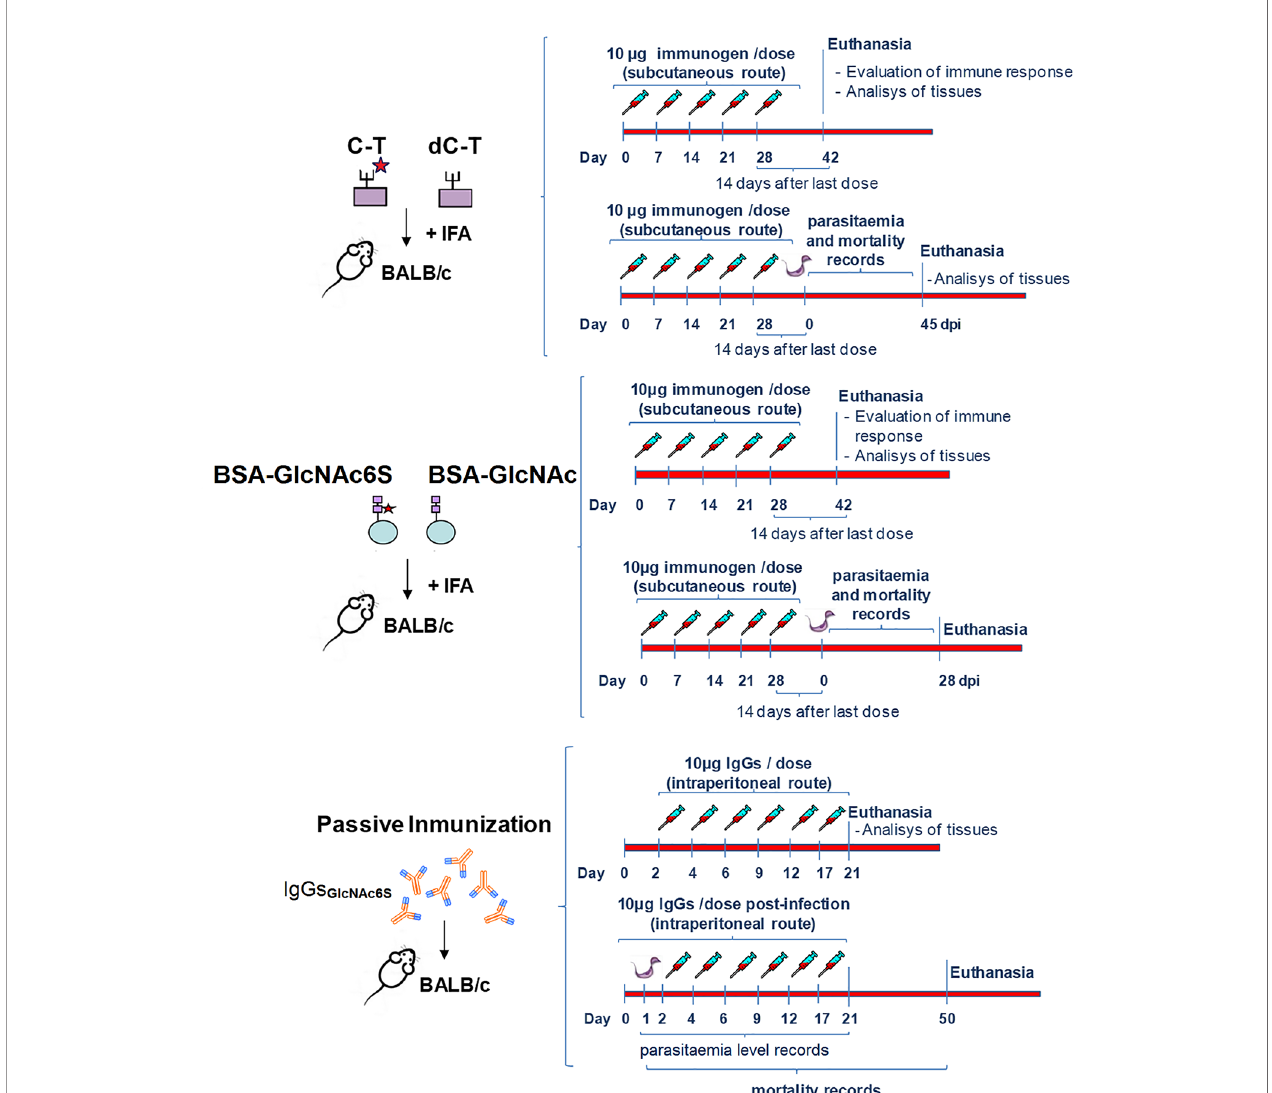
FIGURE 1 | General scheme of immunization from BALB/c mice to study: the input of sulfotopes (GlcNAc6S) in cardiac muscle tissue immunopathology and immune responses, in absence of T. cruzi infection, and the participation of the GlcNAc6S during the infection by T. cruzi. The scheme details the immunization plans performed with the different immunogens and the passive transference of IgG-GlcNAc6S. The immunization scheme with C-T and dC-T was performed in BALB/c female mice (6 – 8 weeks old; n = 10 animals per group). Five weekly doses of C-T or dC-T (10 m g each), emulsi fi ed with IFA (v/v, 1/1) were subcutaneously administered. Control groups received injections with either PBS or with PBS-containing reaction media for solvolysis and were all subjected to the same procedure conditions than the desulfated immunogens plus IFA (Acosta et al., 2008). The immunization scheme with BSA-GlcNAc and BSA-GlcNAc6S was also performed in BALB/c female mice (6 – 8 weeks old; n = 12 animals per group). Five weekly doses of BSA-GlcNAc or BSA-GlcNAc6S (10 m g each), emulsi fi ed with IFA (v/v, 1/1) were subcutaneously administered. Control group mice were immunized with BSA+IFA following the same scheme. In both schemes of the immunization, half of the immunized animals with C-T/dC-T; BSA-GlcNAc6S/BSA-GlcNAc and the respective controls were euthanized to evaluate the immune response and perform a tissue analysis, while the other half of immunized mice were submitted to sublethal challenge with 2 × 10 3 trypomastigotes from Tulahuen 2 (Tul 2) strain, 14 days after the last immunization dose, respectively. Parasitemia was determined each 2 – 3 days up to negative counting in all groups, and deaths were daily recorded. All the survived mice were subjected to euthanasia in each scheme. For passive transference of antibody assay, BALB/c female mice (6 – 8 weeks old) were separated in three groups ( n = 5 mice per group) and received 6 doses of 10 m g from puri fi ed IgGs; each were administered by intraperitoneally in days 2, 4, 6, 9, 12, and 17. The groups were treated with IgG-GlcNAc6S, puri fi ed from mice sera of BSA-GlcNAc6S IM , and puri fi ed IgG-pre-imm. Control groups received Phy-Sol administered intraperitoneally. On the other hand, BALB/c female mice (6 – 8 weeks old) were separated in three groups ( n = 5 mice per group) and were intraperitoneally infected with 500 T. cruzi blood trypomastigotes, Tul 2 strain, the day before to the start of the passive administration for the antibody scheme. A total of 6 doses of 10 m g from puri fi ed IgGs each were administered intraperitoneally in days 2, 4, 6, 9, 12, and 17. The mice groups were treated with IgG-GlcNAc6S (IgG-GlcNAc6S- TM ), IgG-pre-imm (IgG-pre-imm- TM ), and Phy-Sol. Control groups received Phy-Sol administered intraperitoneally. Parasitemia was monitored each 2 – 3 days until the fourth day after the last dose of IgGs was administered. Deaths were daily recorded. Euthanasia was performed on days 21 and 50 for tissue analysis and survival recording, respectively. The sublethal infective doses have been selected both by previous experience in the laboratory group and based on bibliography (Lu et al.,